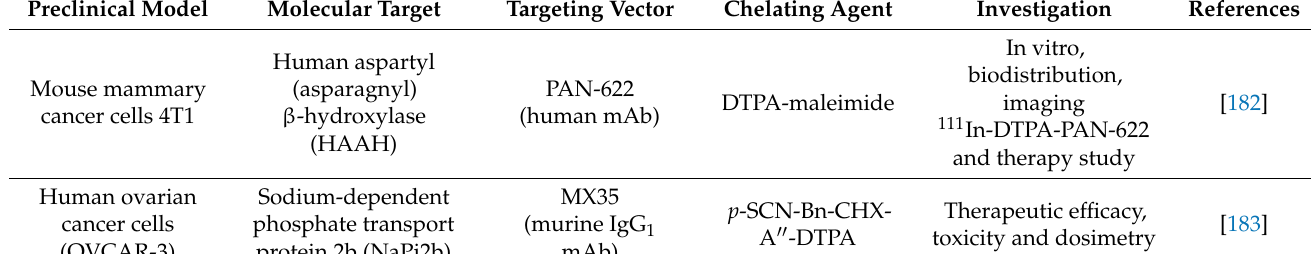
Table 3. 213 Bi preclinical studies involving an identified pathology model (non-exhaustive